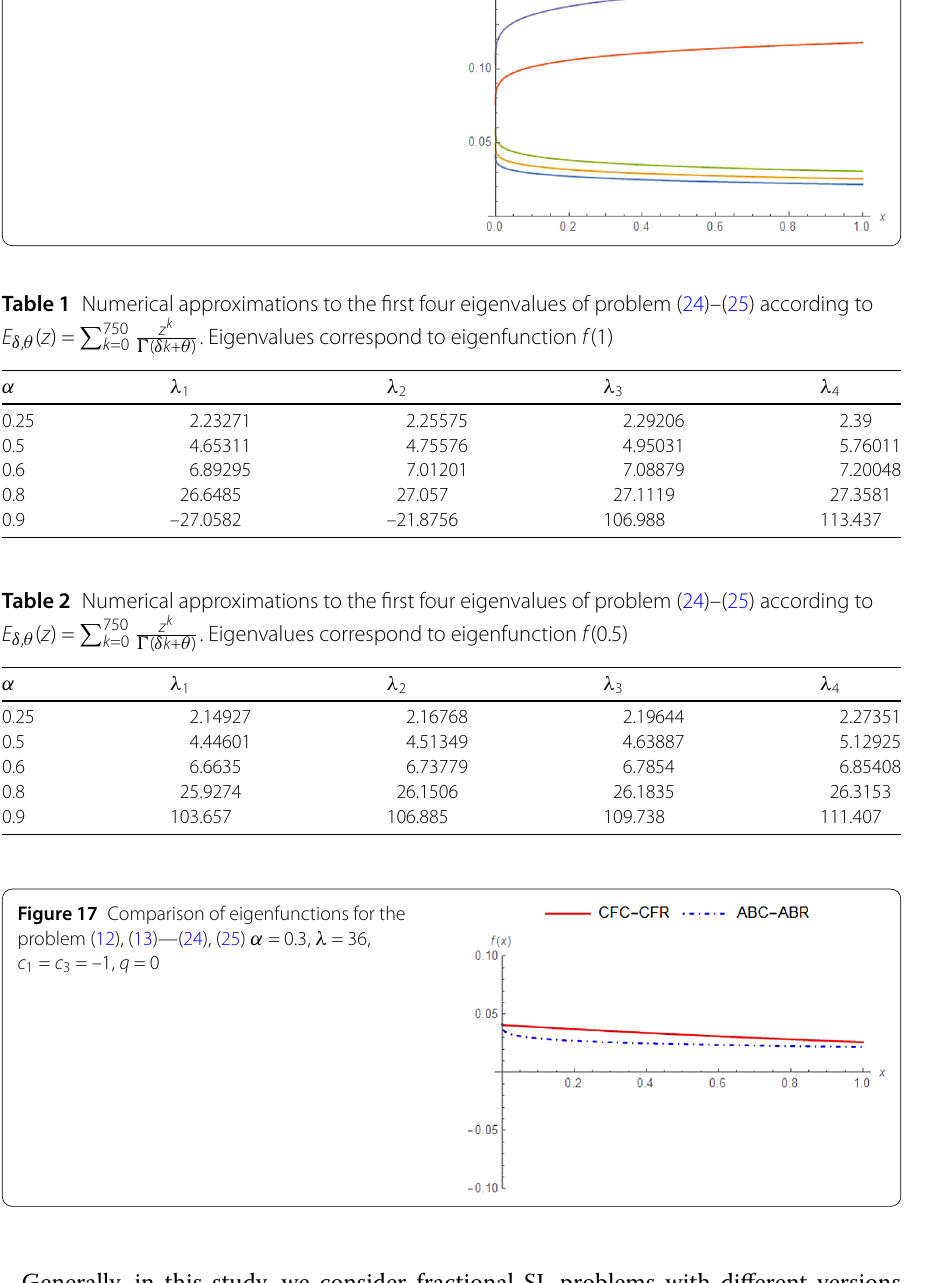
Figure 16 Comparions of eigenfunctions for the problem (24), (25) under different potentials λ = 36, α = 0.3, c 3 = –1